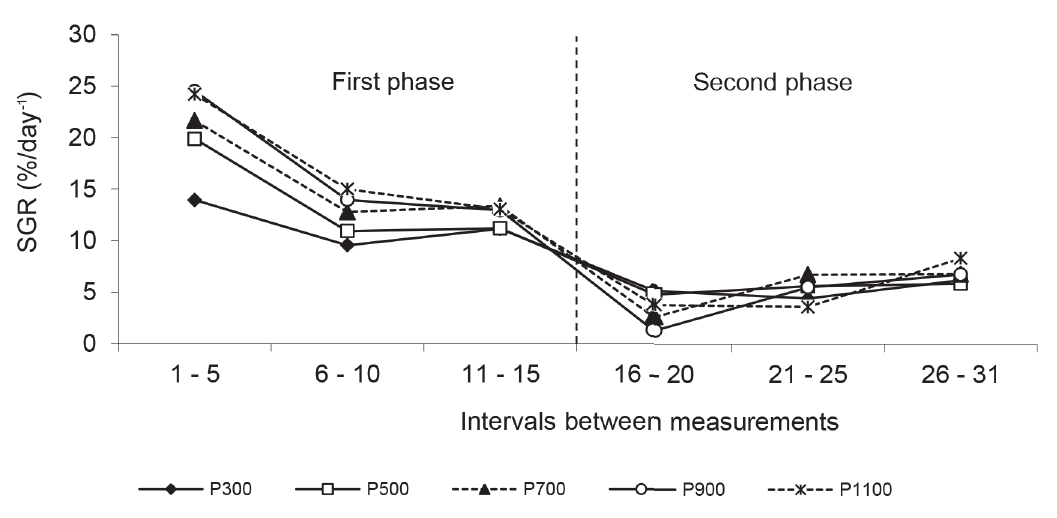
Figure 2 - Mean values of specific growth rate (SGR) (% day -1 ) of Hoplias lacerdae larvae and juveniles under different prey concentrations (first experimental phase) and feed training (second experimental